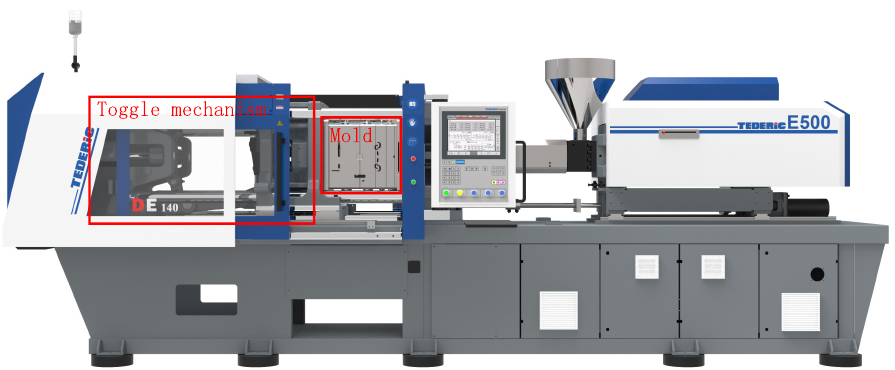
Figure 1. Electric injection molding machine with a mold. If there are some foreign bodies in the mold without protection, the mold will be damaged when the mold closes. Generally, the mold is expensive, and the maintenance is